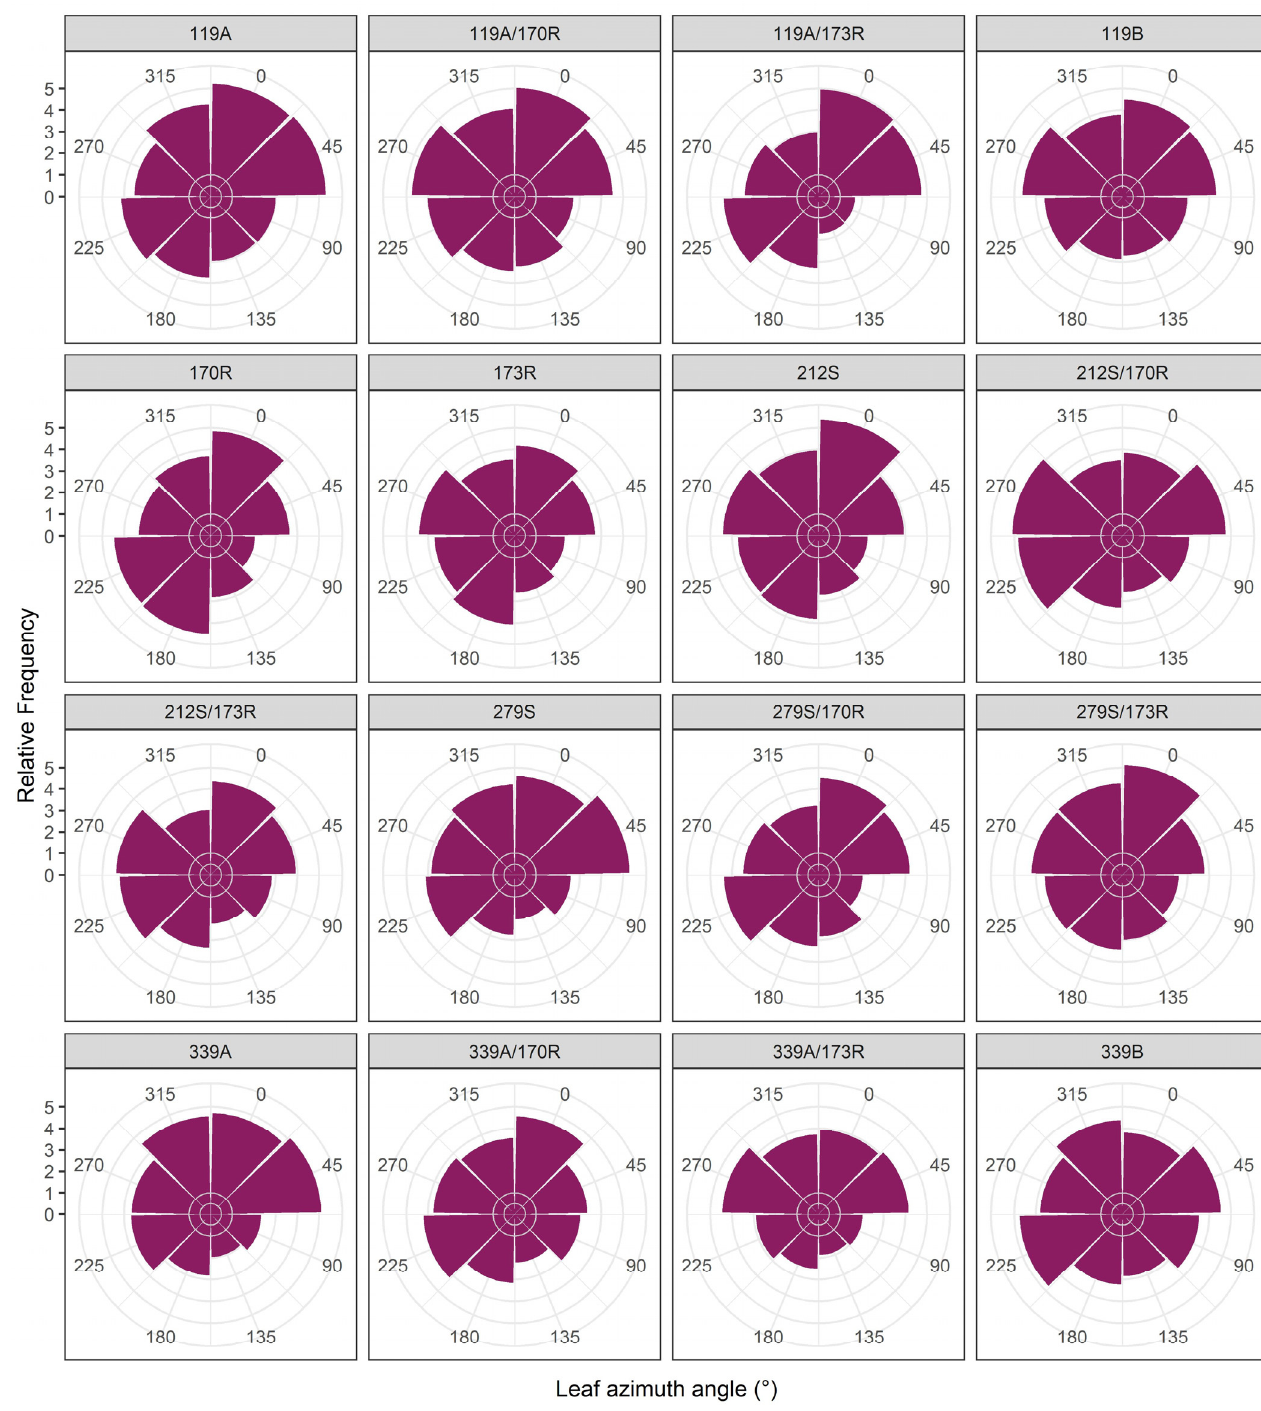
Figure 7. Relative frequency distribution of leaf azimuth angles around stems for different rice genotypes (based on field-scanned data from 2019).